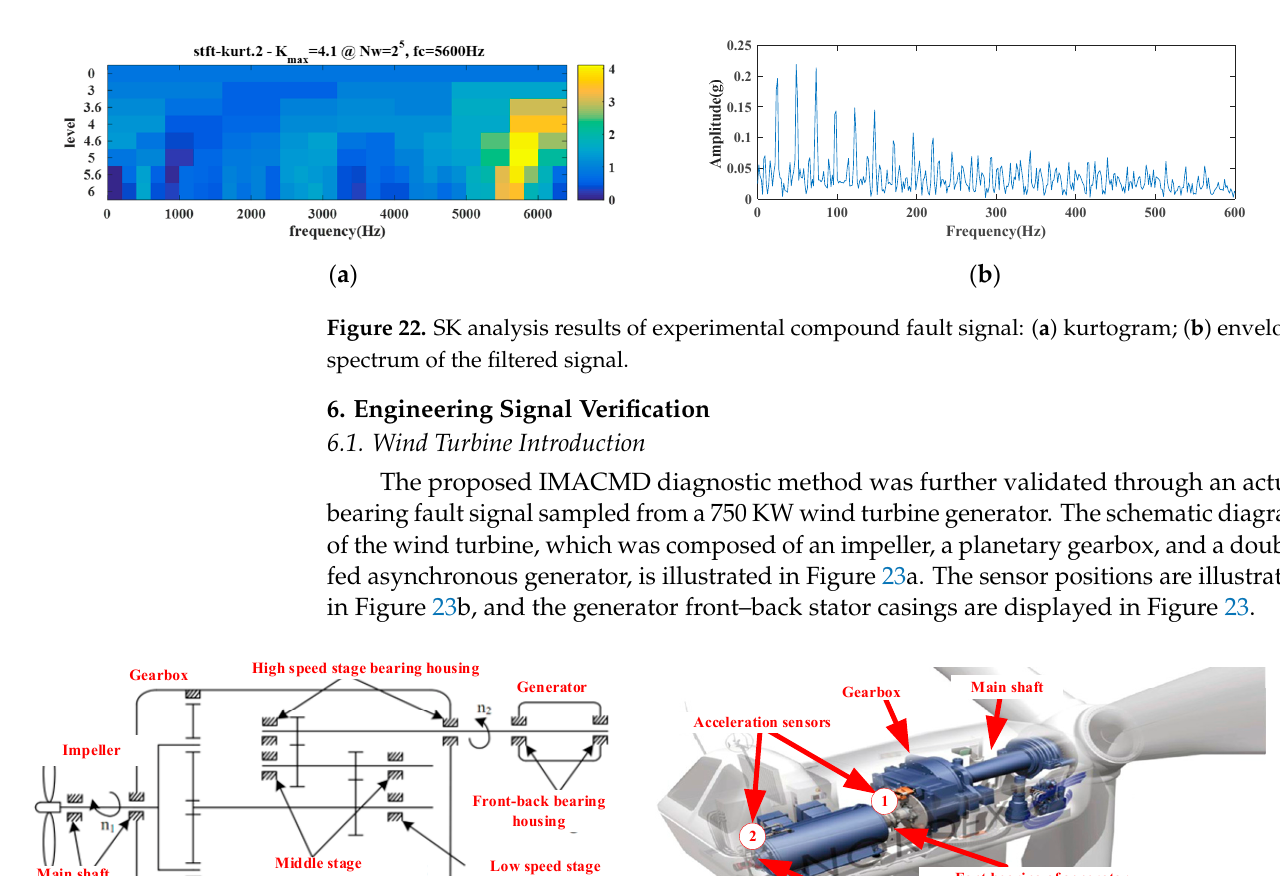
Table 3. Parameters of the SKF6324 bearing.